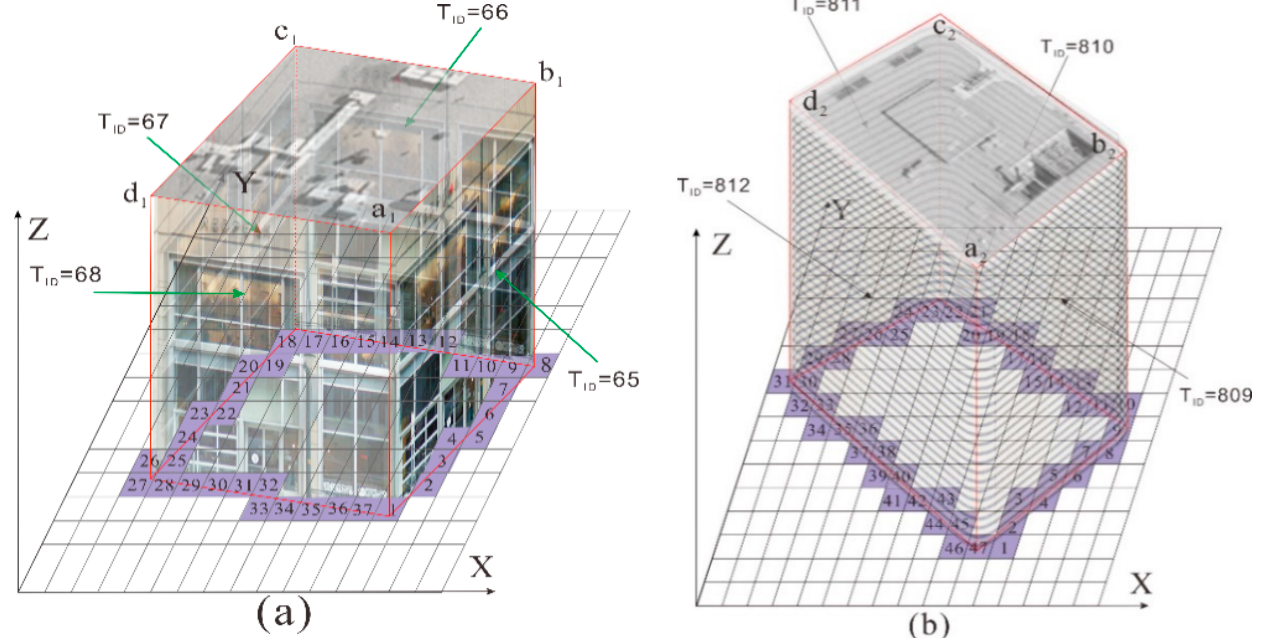
Figure 7. Building 3D spaghetti data structure, where TID represents the wall texture ID (e.g., T = 809); a 1 , b 1 , c 1 , d 1 , a 2 , b 2 , c 2 , and d 2 represent building’s roof corners. ( a ) 3D data structure of a building with a height of 25.8 m; ( b ) 3D data structure of a building with a height of 46.4 m. Table 2. The building wall texture superpixel data in Figure 7a. Table 3. The building façade texture superpixel data in Figure 7b. Pixel